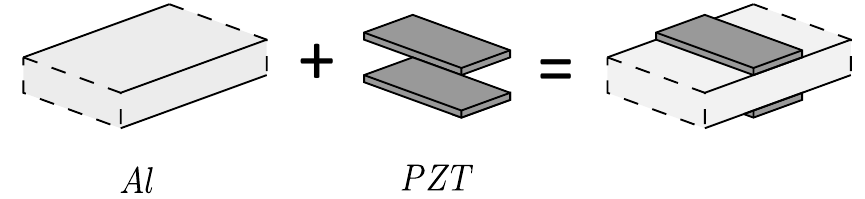
Figure 4. Construction of inertia and stiffness matrices in the case of the